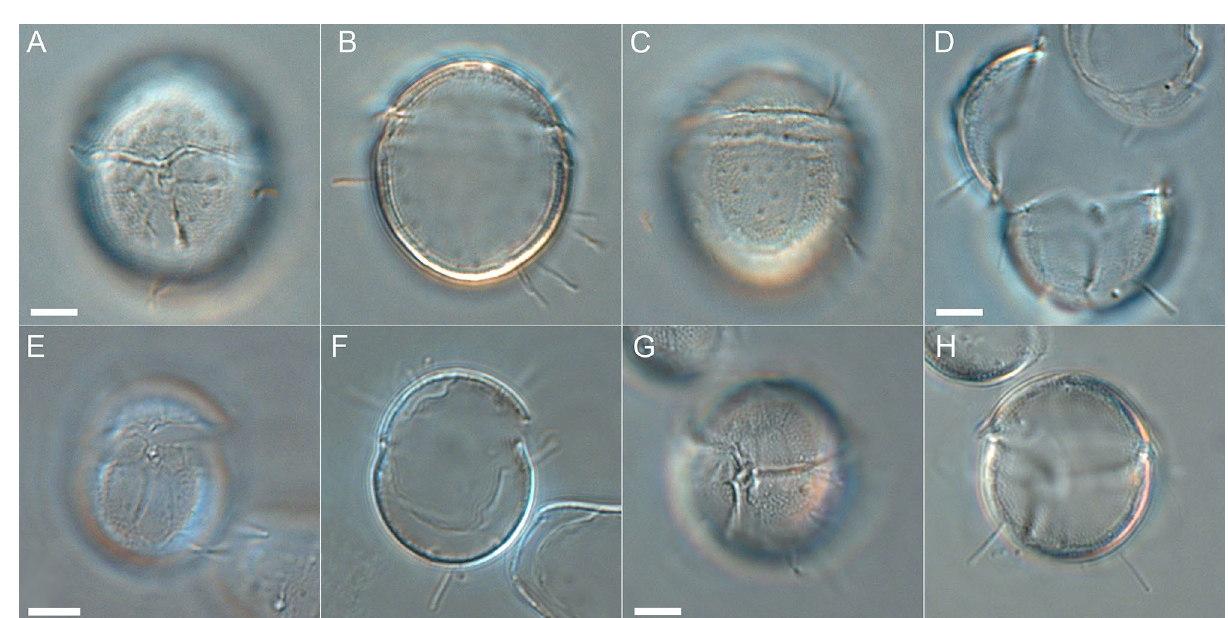
Figure 6. Scanning electron micrographs of Fensomea setacea , gen. & sp. nov . (GeoB*184), showing detailed views of ( A – E ) slender processes and ( E – H ) pore-like structures (black arrows) in the plates. Note the bipolar differentiation of the processes, which have striate proximal ends and glabrous distal ends. Scale bars = 2 µm.